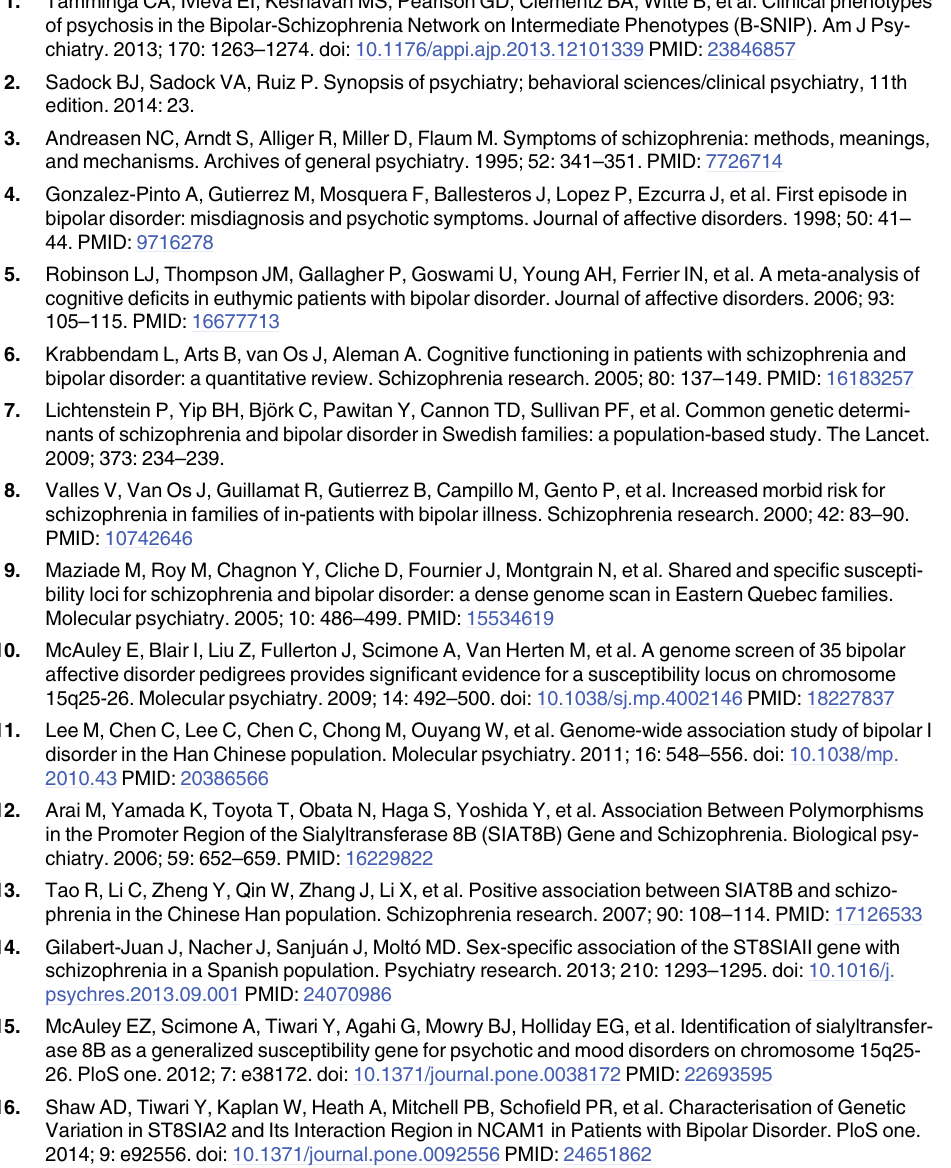
S1 Table. Detailed results of association analysis of ST8SIA tag single nucleotide polymor- phisms with schizophrenia and bipolar